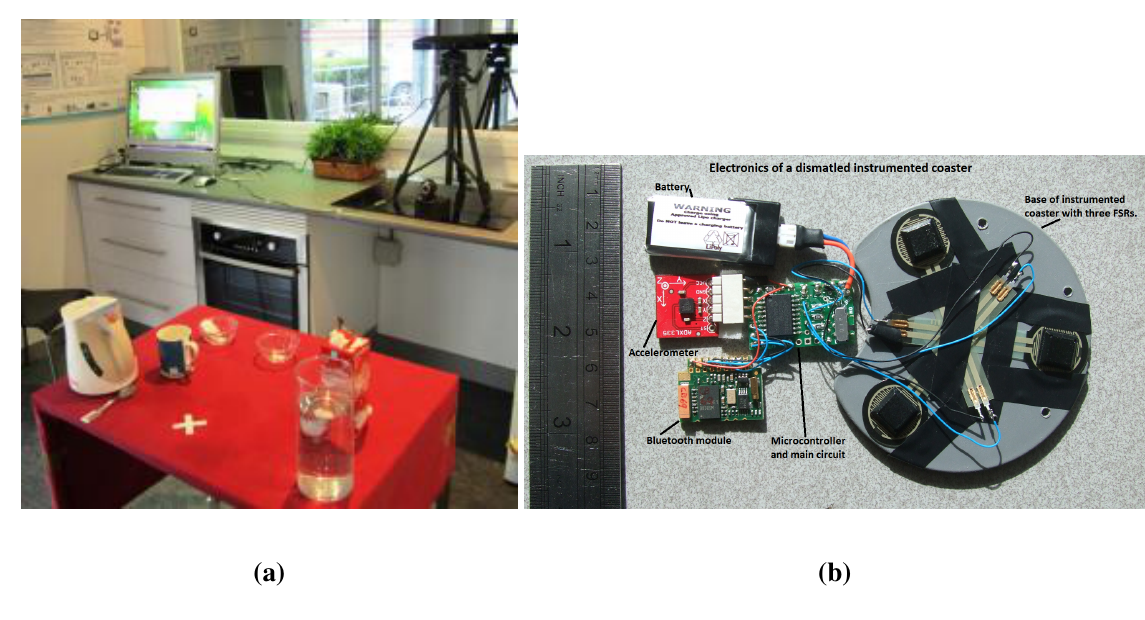
Figure 6. The test settings of the CogWatch system. ( a ) The CogWatch test workspace; ( b ) An example of the CogWatch smart